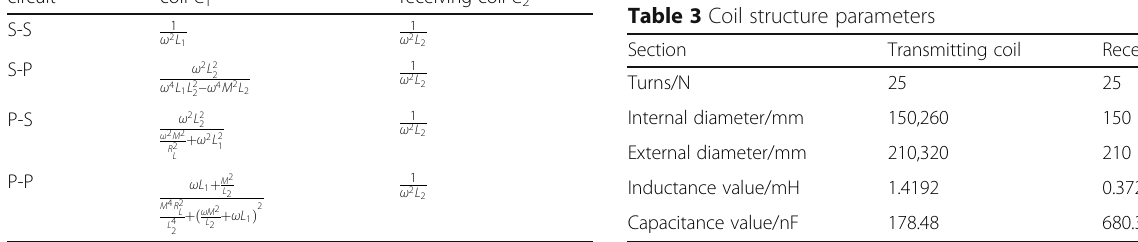
Table 2 Capacitance values of four compensation circuits Compensation Capacitance of transmitting circuit coil C 1